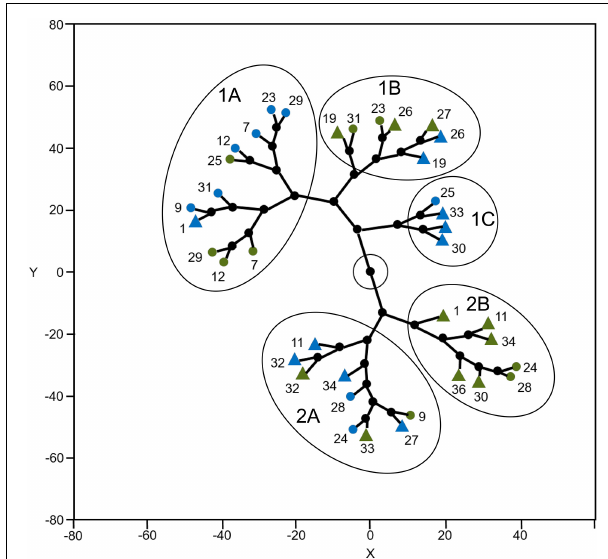
FIGURE 6 | Constellation plot clustering climbing accessions and environment of cultivation based on the variables assessed in this study. M and green = cultivated in the mountain; S and blue = cultivated in the sea level; o = accession related to the Mesoamerican domestication center; (cid:49) accession related to the Andean domestication